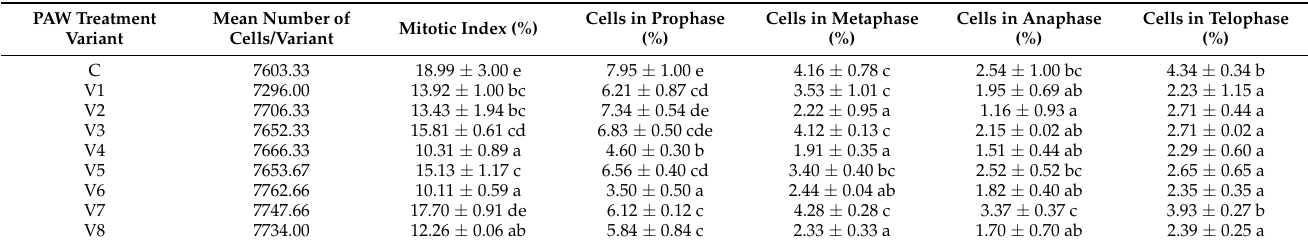
Table 2. Mitotic Index and distribution of mitotic phases on the root tips of Triticum aestivum treated with non-thermal plasma-activated